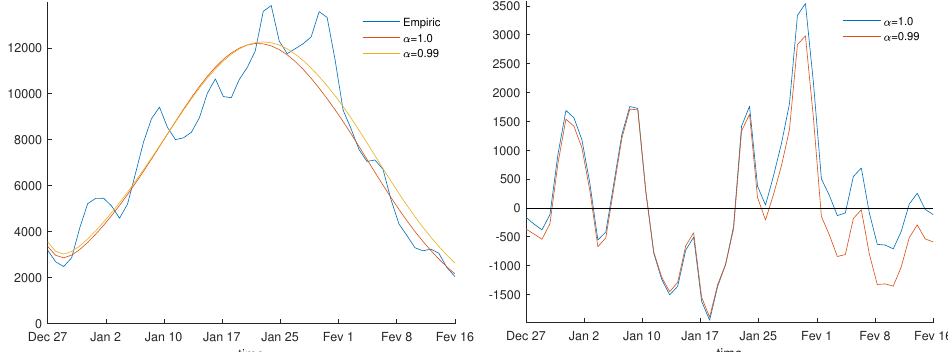
Figure 3. ( left ) The number of confirmed cases per day in Portugal versus the ones predicted by Model (2) with parameters given by Table 1. The blue line corresponds to the real data ( I + P + H ) and the remaining lines have been obtained solving numerically the system of fractional differential equations (2). ( right ) The difference between the number of confirmed cases per day and the number of estimated cases, the solution of